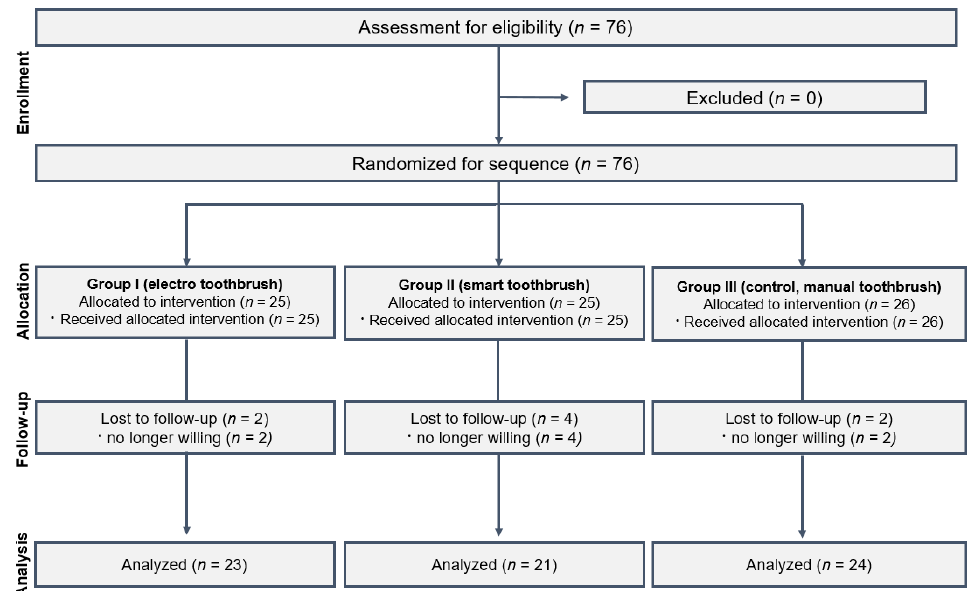
Figure 1. Flowchart of the participants in the randomized clinical trial. Group I was assigned to a brush with an ET (Oral-B, Procter and Gamble, Kronberg, Germany), which had a combination of a rotation oscillation movement. Group II brushed with ST (ZiuSolution, Gyeonggi, Republic of Korea) that could be attached to the classic toothbrush. Group III used an MT (AIOBIO, Seoul, Republic of Korea) (Figure 2). The total number of subjects were 23, 21, and 24 in groups I, II, and III, respectively.